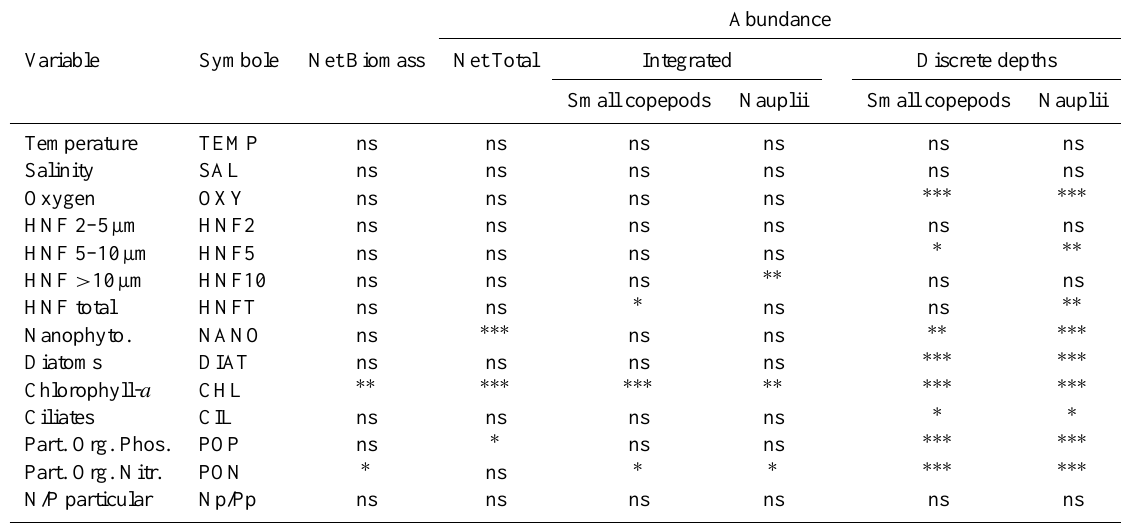
Table 3. Simple correlation analysis between zooplankton parameters and environmental factors: significance degree of p values.